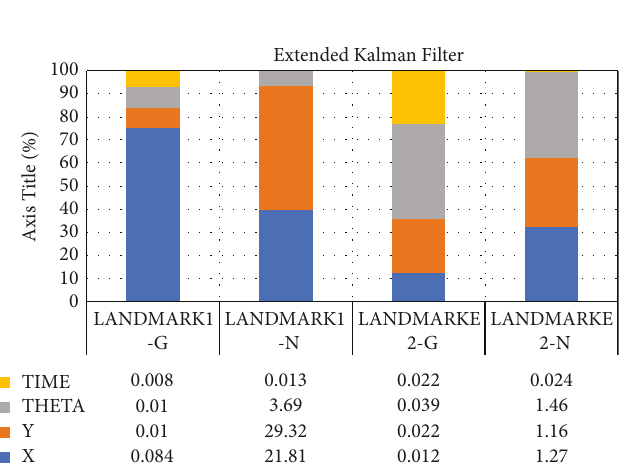
Figure 21: Simulation results analysis of the EKF.